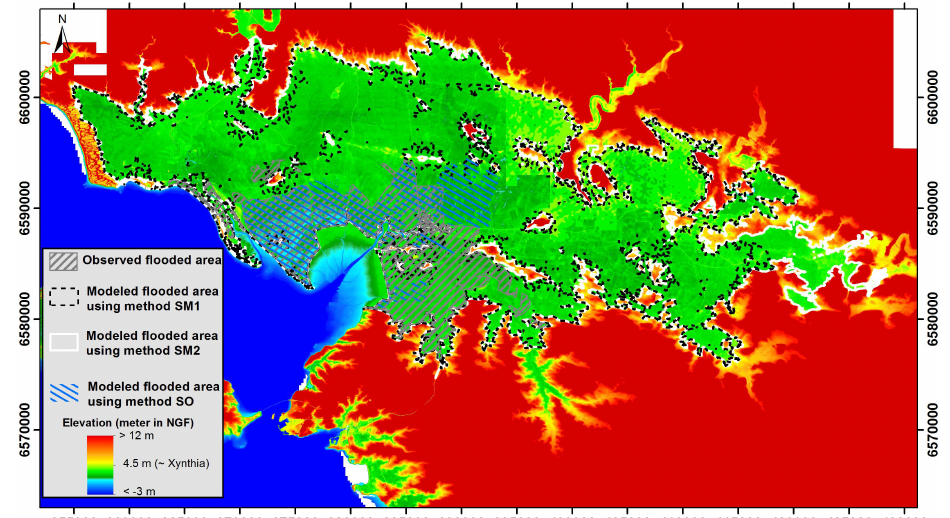
Fig. 9. Digital Terrain Model (DTM) of the Poitevin Marsh (no. 27) showing the observed flooded area (hatched grey lines) and the modeled flooded area from methods SM1 (dashed black line), SM2 (solid white line) and SO (hatched blue lines).